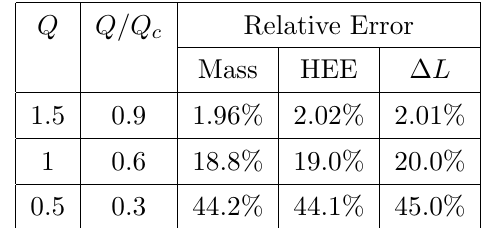
Figure 7 . The proportionality of (cid:1) L and M . These plots show the isocharges in the black hole mass-(cid:1) L plane for the charged AdS black hole in d = 4 dimensions. The graphs verify that (cid:1) L / M and thus that there is not an equal area law for (cid:1) L .